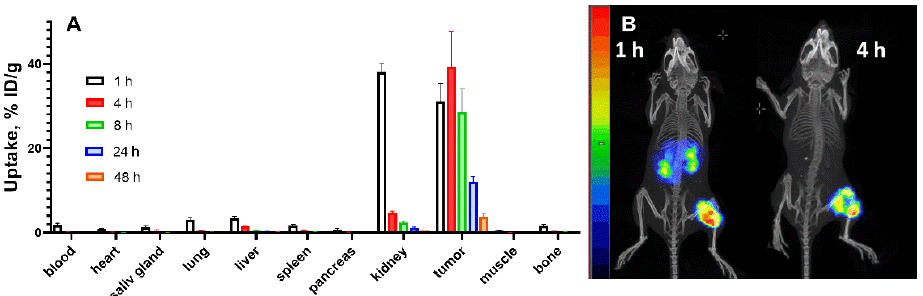
Figure 6. ( A ) Biodistribution of 188 Re-ZHER2:41071 in BALB/C nu/nu mice bearing HER2-expressing SKOV-3 xenografts. Data are presented as an average ( n = 4) value ± SD. ( B ) Imaging of BALB/C nu/nu mice bearing HER2-positive SKOV-3 xenografts using 188 Re-ZHER2:41071 at 1 and 4 h after injection. The scale is linear showing arbitrary units normalized to a maximum count rate.